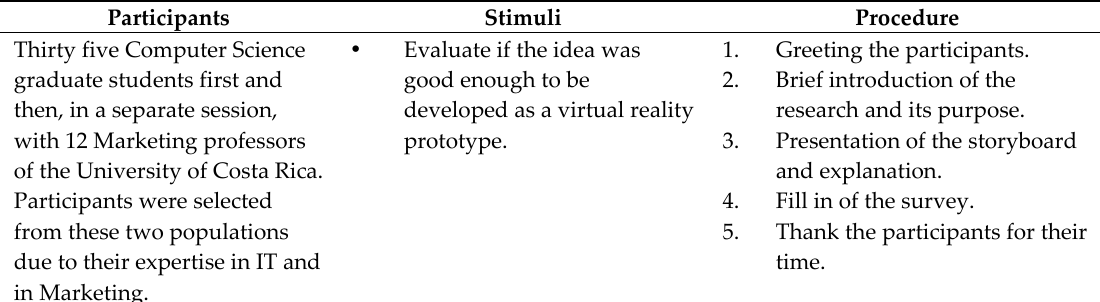
Table 1. Storyboard evaluation structure.